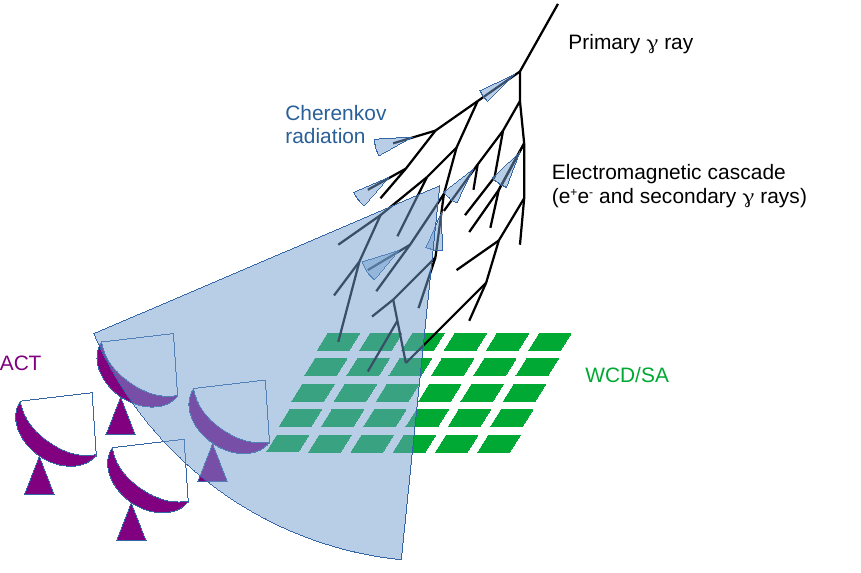
Figure 2. Principle of TeV gamma ray detection. Primary gamma ray interacts with atmospheric nuclei, creating a cascade (atmospheric shower) of secondary particles (black lines). Charged particles, with their speed exceeding the speed of light in the atmosphere, induce the emission of Cherenkov light flashes (blue cones). The radiation can be observed using IACTs (violet). Those of the secondary particles that reach the ground level can also be detected directly through WCD or SA experiments